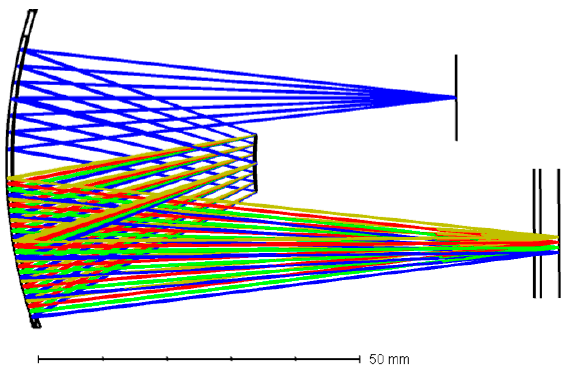
Figure 9. Configuration of the Offner spectrometer.